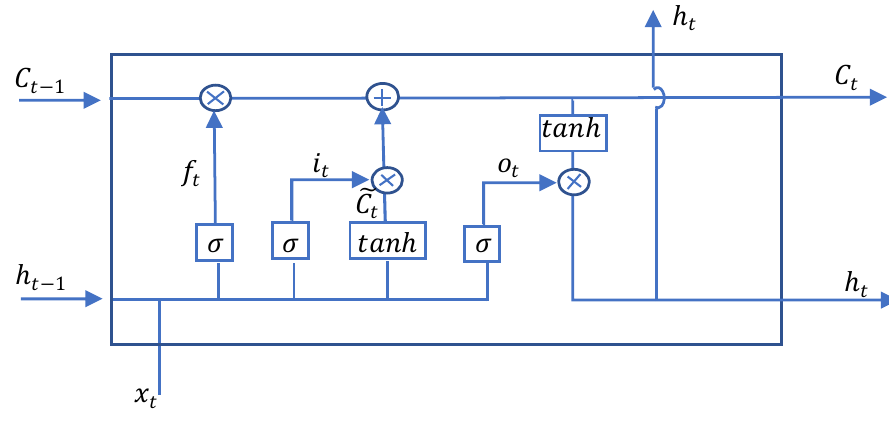
Figure 1. Structure of an LSTM unit.